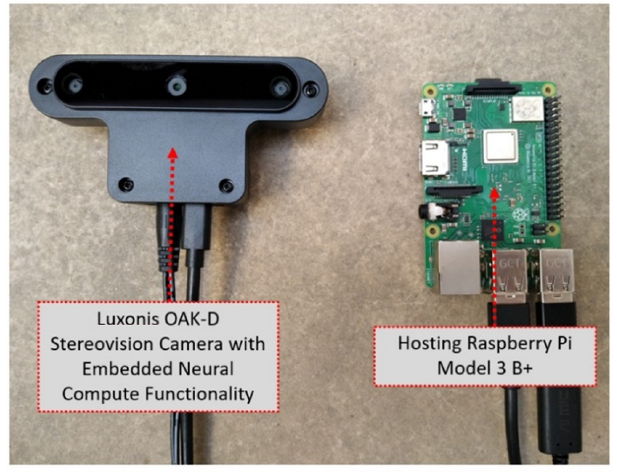
Figure 9. A Luxonis OAK-D stereovision camera that incorporates neural compute functionality, as an implementation variant enhancing the robot presented in [145].